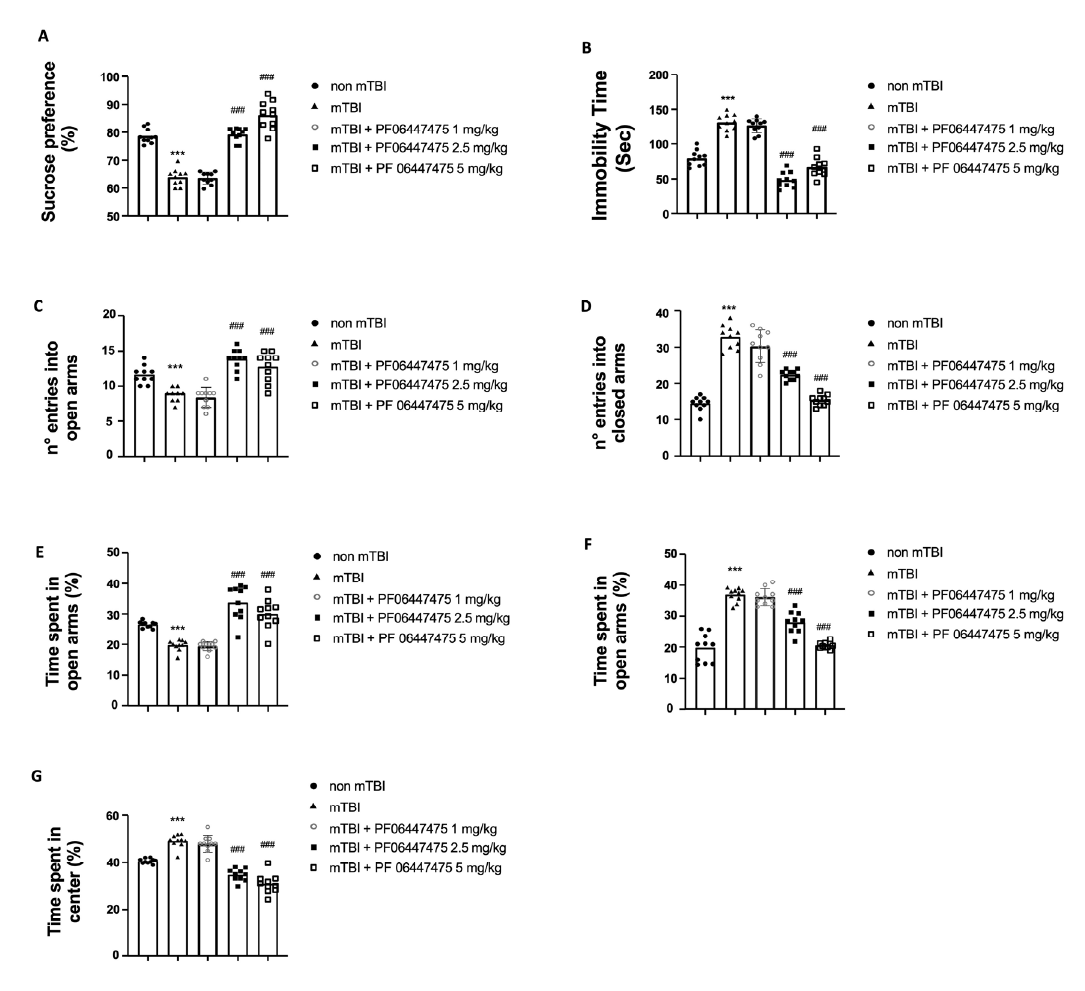
Figure 6. Effect of PF-475 treatment on behavioral function. The sucrose preference test showed that mTBI significantly reduced the percentage of sucrose preference, while PF-475 (2.5 and 5 mg/kg) restored it ( A ). The forced swim test demonstrated that the increased immobility time induced by mTBI in mice was decreased after treatment with PF-475 at doses of 2.5 and 5 mg/kg ( B ). The elevated plus maze test showed that PF-475 treatment (2.5 and 5 mg/kg) reduced depression symptoms after mTBI induction, reducing the number of entries and time spent in closed arms ( D , F ); PF-475 increased the number of entries and time spent in open arms ( C , E ) and reduced the time spent at center ( G ). Data was expressed as SD from 10 mice for each group. Two-way ANOVA test. *** p < 0.001 vs. non mTBI; ### p < 0.001 vs. mTBI.